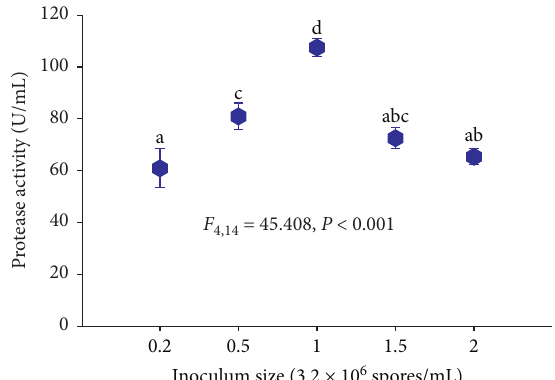
Figure 6: Effect of inoculum size on the production acid protease by the isolate Z1BL1. Different letters (a, b, c, d) designate sig- nificantly different means as determined by the SPSS test ( P < 0 . 001 ) ; initial media pH 4.5; temperature 30 ° C. F P < 0.001 1,5 = 32.585,